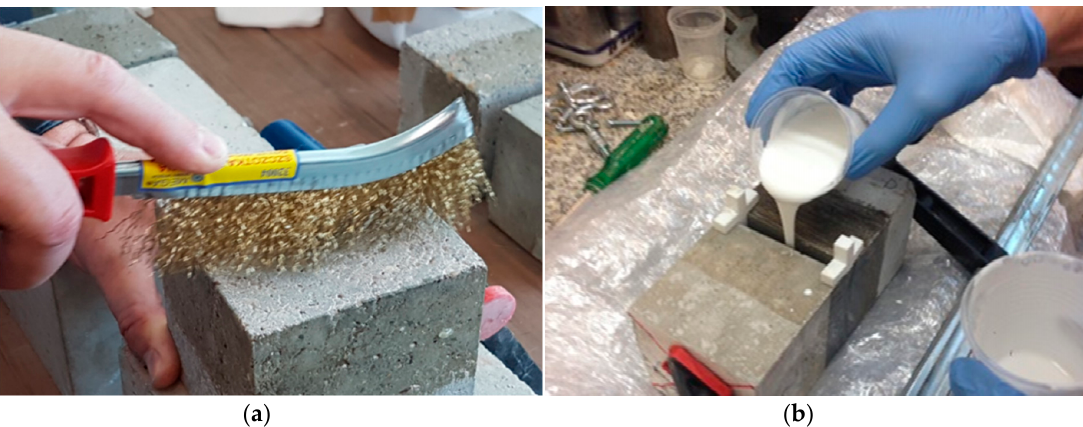
Figure 4. Preparation of a specimen for tests: ( a ) cleaning the surface and ( b ) pouring the resin into the expansion joint.